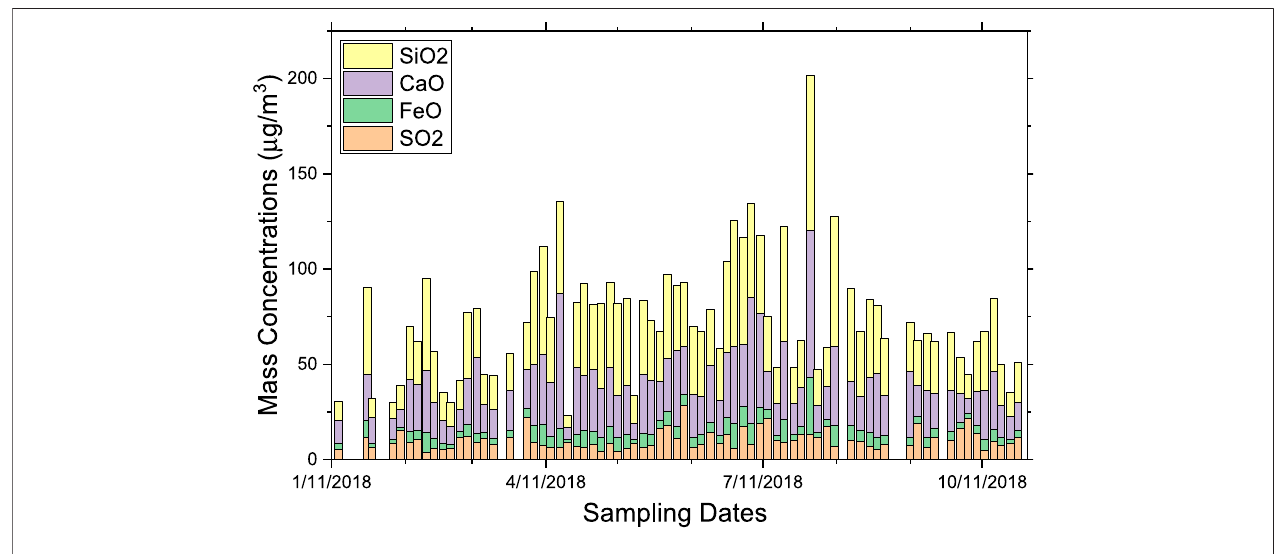
FIGURE 3 | Variation of the mass concentrations of Si, Ca, Fe and S in PM 10 .